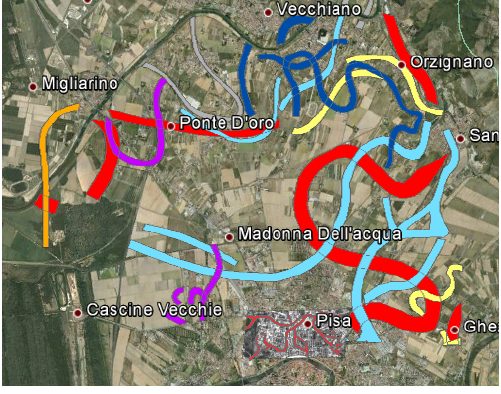
Marcello Cosci. Different colors correspond to different kinds of analyses on different photo sources. Red, light blue, blue: Landsat, Soyuz and Spot satellite imagery; Purple, orange: RAF and Regione Toscana aerial imagery; Yellow: multispectral imagery ( c (cid:13) Marcello Cosci Aerial Photography Documentation Centre. c (cid:13) 2010